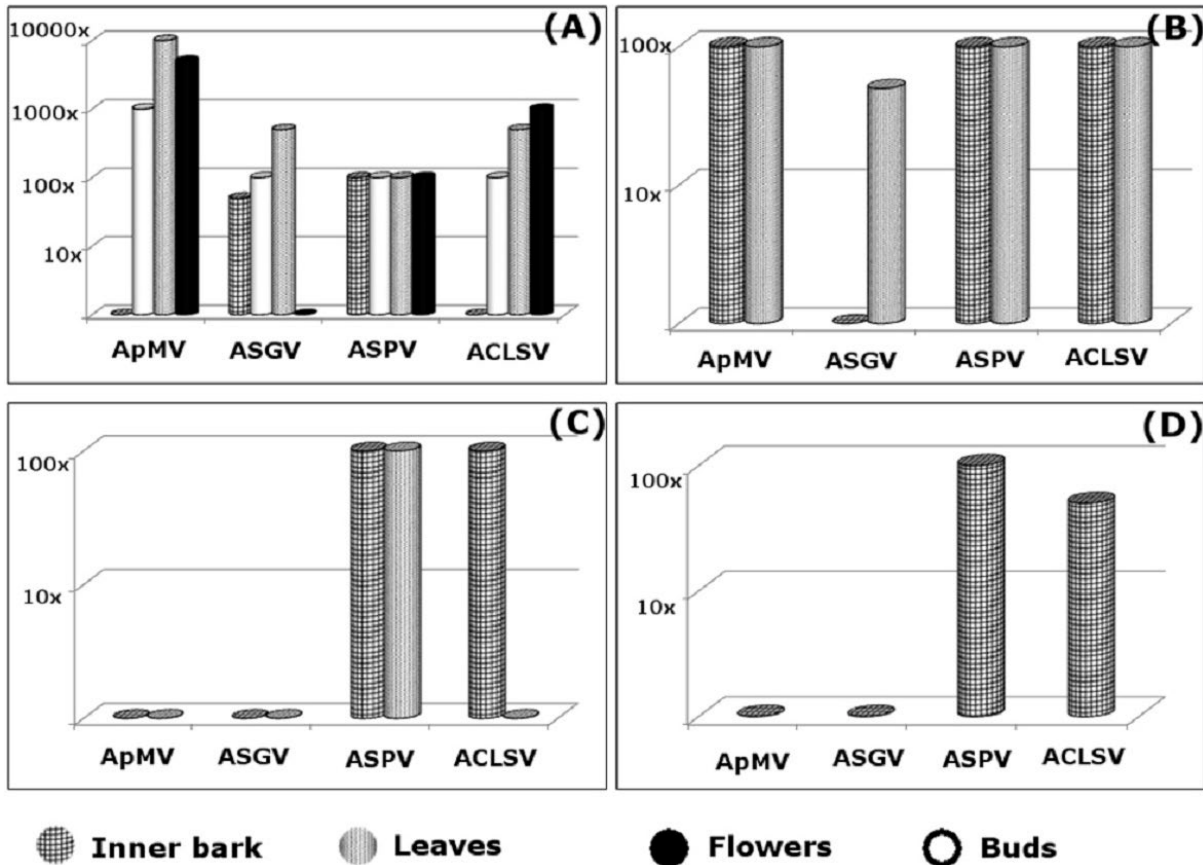
Figure 4. Comparison of the relative concentrations of Apple mosaic virus , Apple stem grooving virus , Apple stem pitting virus and Apple chlorotic leaf spot virus in different plant tissues using DAS/I-ELISA throughout 2014. (A): spring; (B): summer; (C): autumn and (D): winter. The relative concentration is symbolized in the y-axis and is expressed by logarithm dilution series (10×, 50×, 100×, 500×, 1000×, 5000× and